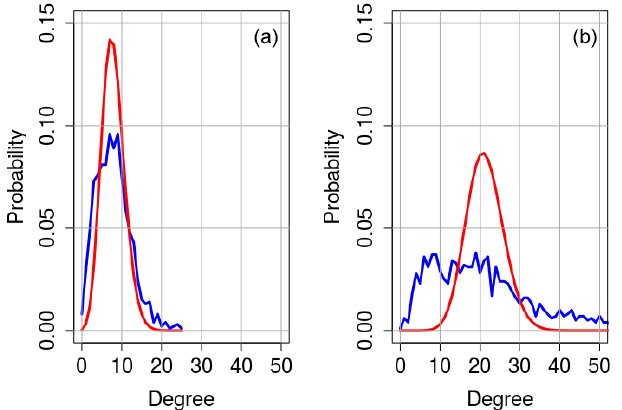
Figure 4. Same as Fig. 1 but for heatwaves in the GE region during